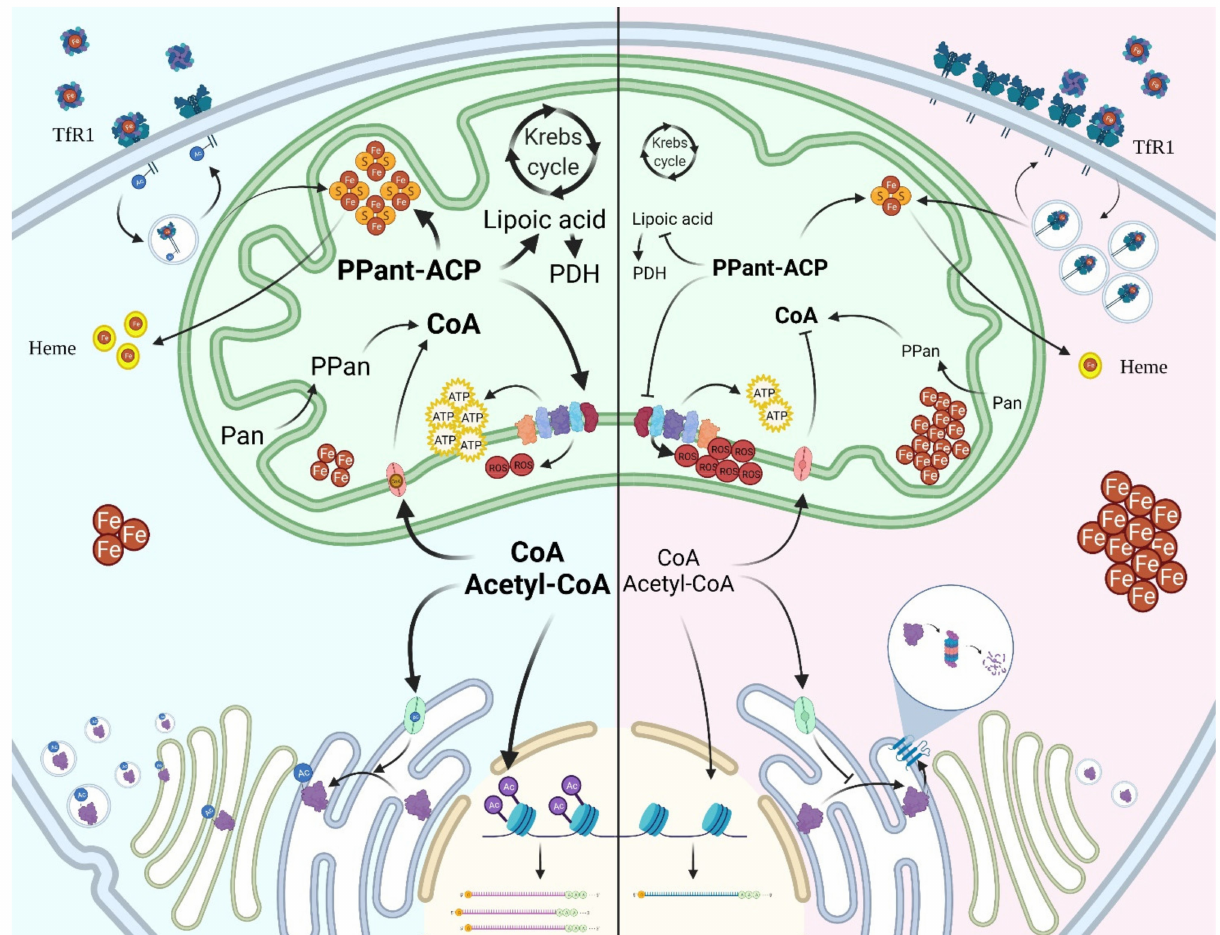
Figure 2. Schematic overview of the biochemical pathways involving CoA in normal (blue panel) or pathological conditions (red panel). The figure recapitulates some of the numerous intracellular processes requiring CoA or its thioester derivatives and found to be affected in disorders due to inborn errors of CoA biosynthesis or to altered compartmentalization. The important roles in the intermediate metabolism and mitochondrial energy production and in protein post-translational modifications (acetylation of histones and ER resident and transiting proteins, palmitoylation of TfR1, pantetheinylation of ACP) are summarized together with the effects observed in total or organellar CoA deficiency (iron accumulation, increased ROS production, defective energy production, reduced efficiency of protein secretion and ER degradation).